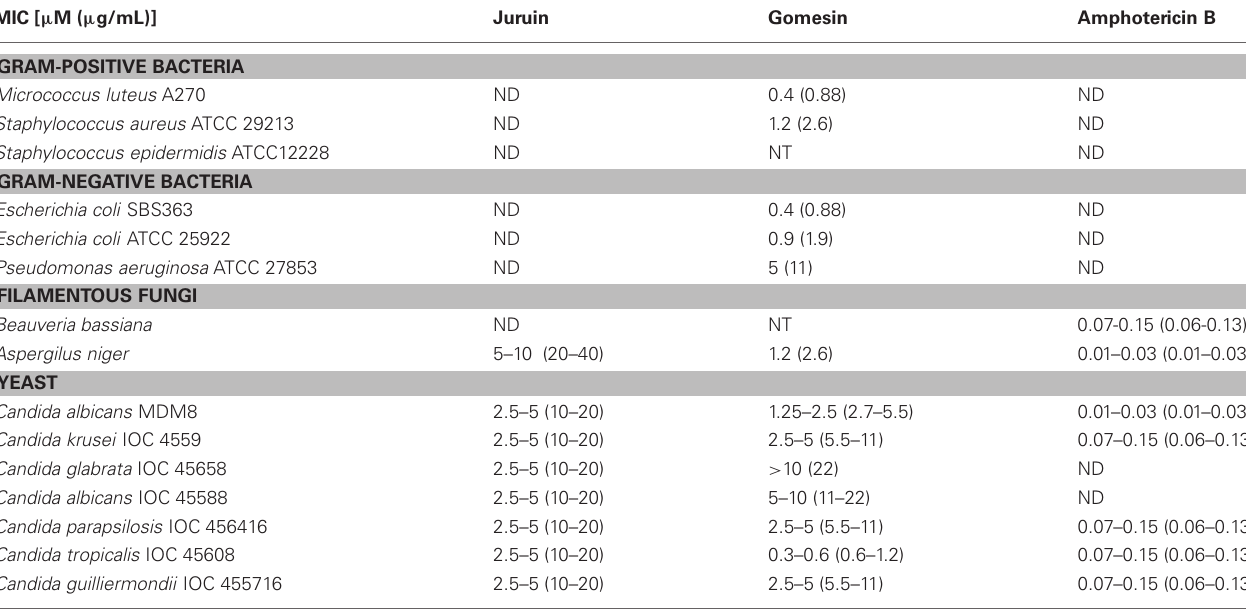
Table 1 | Antimicrobial activities of cysteine-rich antimicrobial peptides against selected microorganisms.